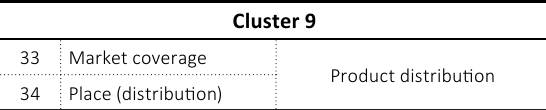
Table 10. Codes comprising Cluster 9